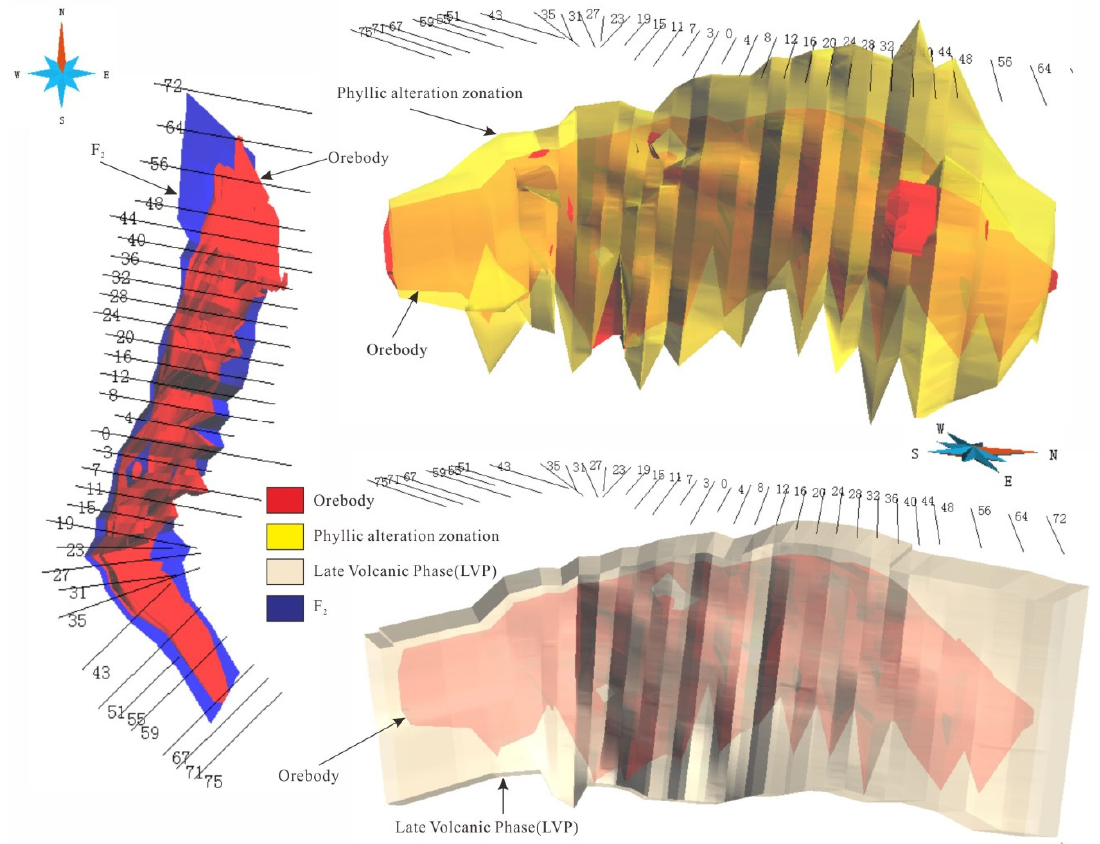
Figure 3. Above; 3D geological models of orebodies, phyllic alteration zone, late volcanic phase (LVP), and fault F 2 in the Axi gold deposit.